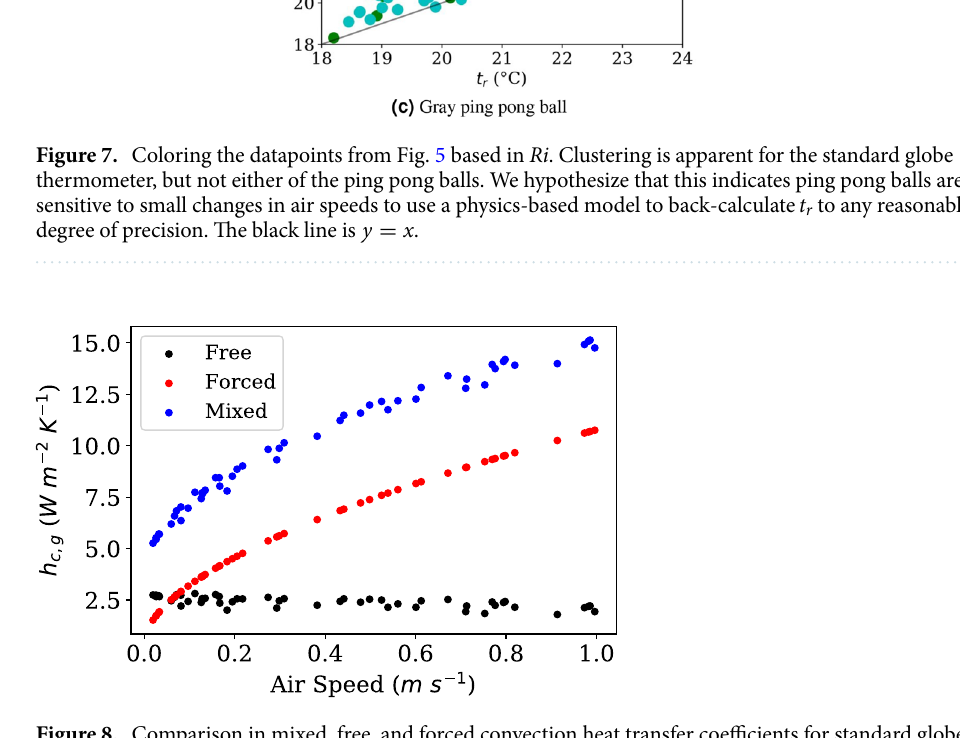
The air speed versus standard deviation of each air speed measurement from all three probes is shown in Fig. 9. Measuring the air speed 25 cm in front of the globes had the highest degree of variability compared to the sensors positioned above and below. Despite the larger uncertainty, air measurements taken from in front of the globe were used in all other plots in this paper for reasons outlined in the Discussion section.